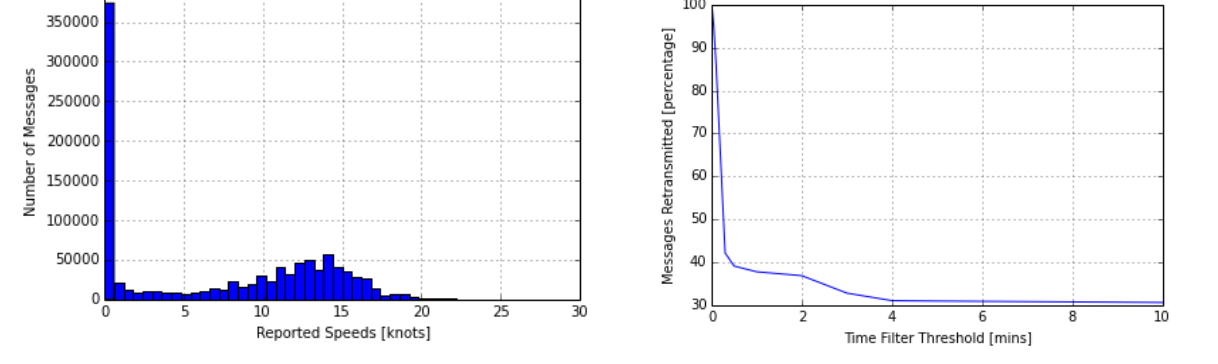
Figure 6. Messages retransmitted after distance